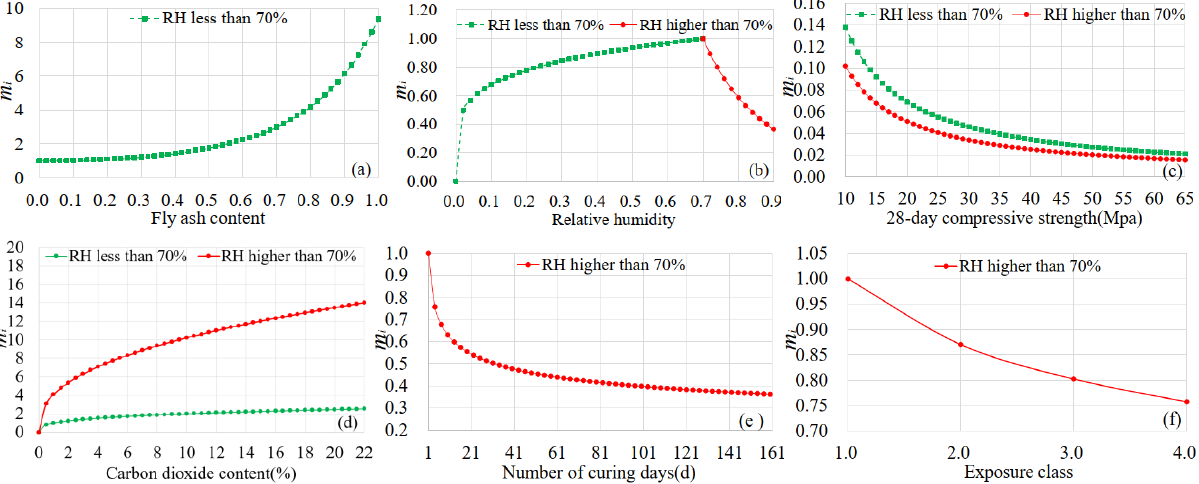
Figure 3. Influence curves of m i of each variable on carbonation coefficient ( a – f ) are the relationship between FA , RH , f c , C , D , X and carbonation contribution coefficient respectively.